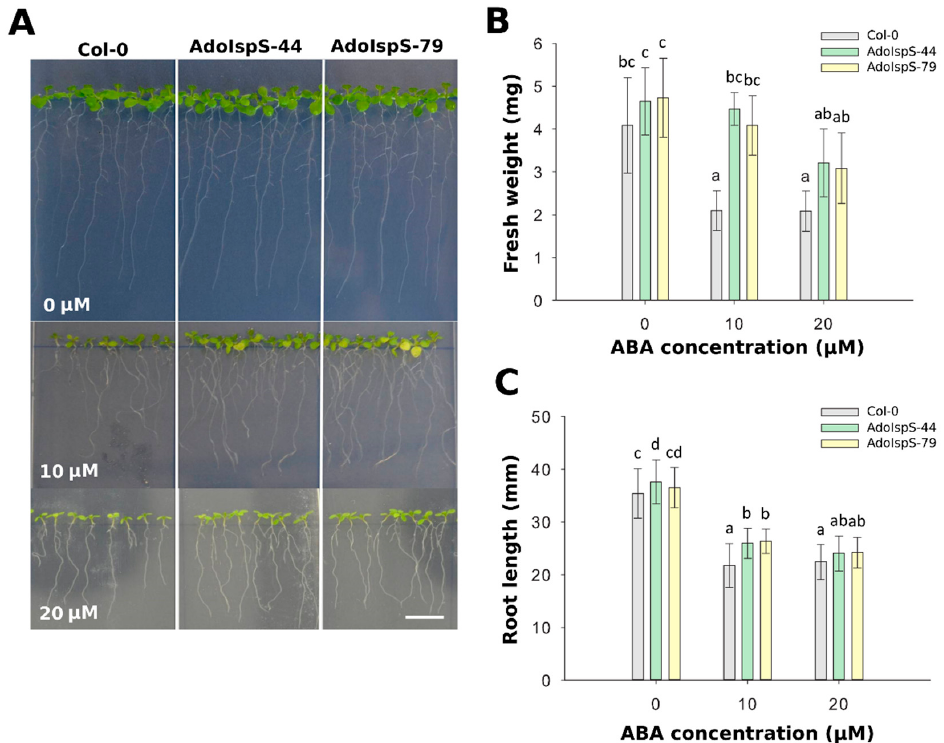
Figure 2. Effect of ABA on fresh weight and root elongation of transgenic lines overexpressing the IspS gene. ( A ) Representative pictures of Col-0 and transgenic seedlings grown on vertical plates and treated for 1 week with 0 µ m, 10 µ m, or 20 µ M ABA. Scale bar = 1 cm. ( B ) Total fresh weight and ( C ) root length of plants treated with different amounts of ABA. Histogram bars marked with the same letter do not significantly differ from each other (Tukey–Kramer test, p > 0.05). Error bars represent the SD of the means.